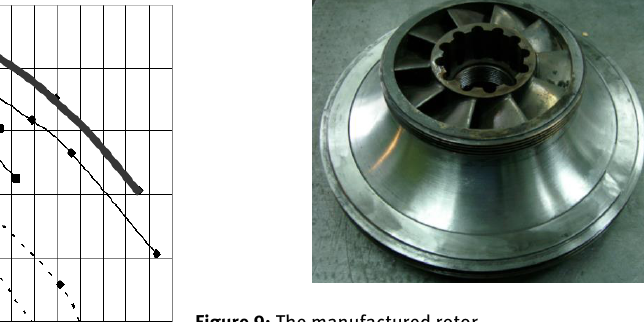
Figure 9: The manufactured rotor